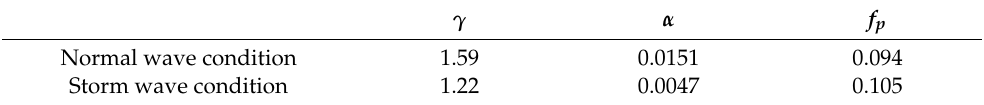
Table 4. JONSWAP parameters for normal and storm wave conditions around the Taitung area.